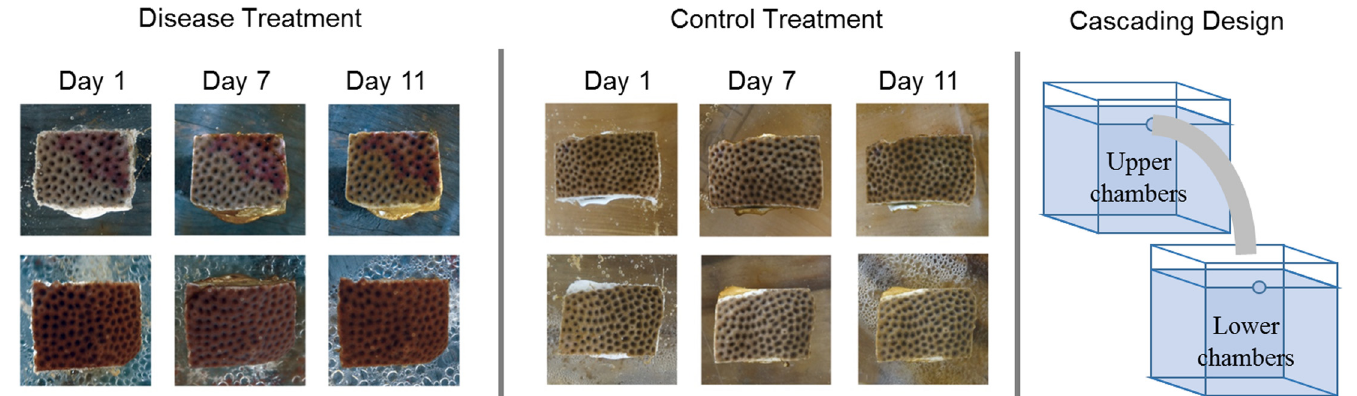
Fig 5. Time-series images of Siderastrea siderea from waterborne-transmission experiments. The top row represents diseased or healthy-coral colonies (~16 cm 2 ), depending on the treatment, from the upper chambers. The bottom row represents healthy-coral colonies (~16 cm 2 ) from the lower